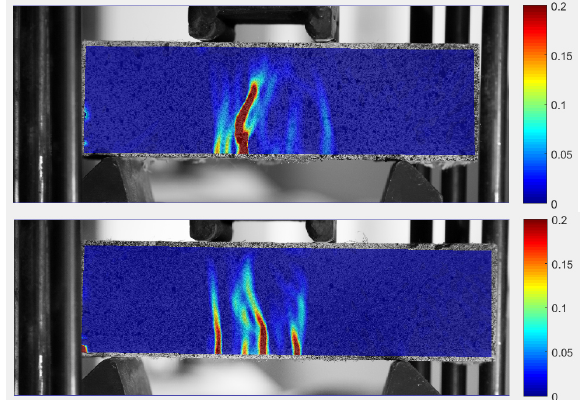
Figure 3. Crack development during four-point bend- ing test of cement sample reinforced with reference (top) and 30 seconds plasma treated (bottom) micro- fibers.